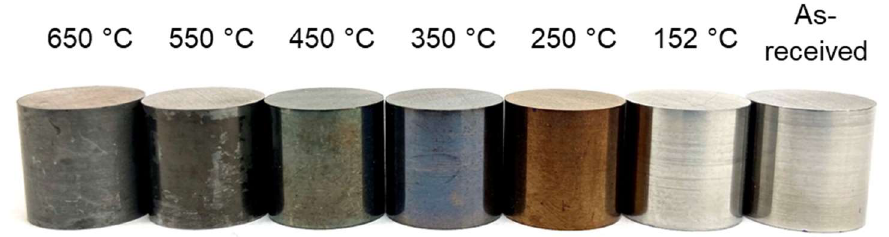
Figure 7. Photograph of the martensitic steel samples after the annealing (at the indicated